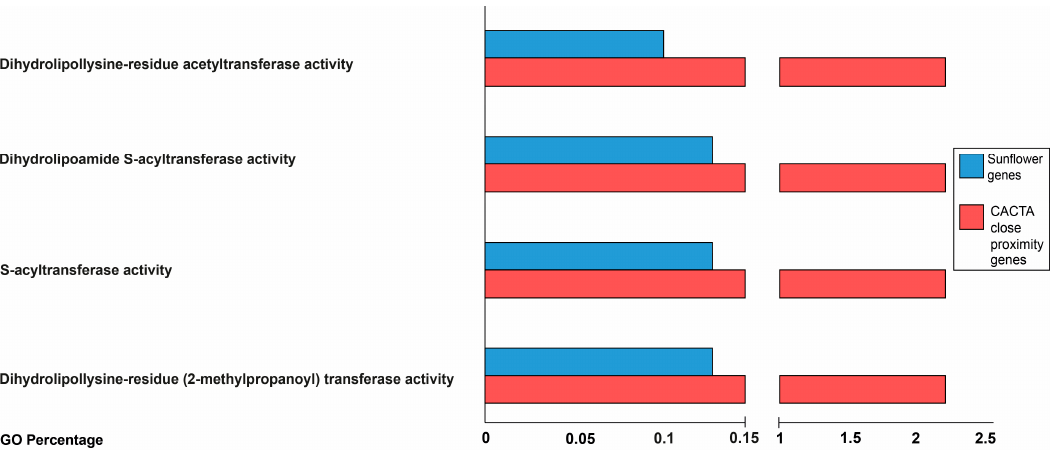
Figure 6. Enriched gene ontology (GO) terms distribution. GO terms of genes in close proximity to elements of CACTA family A (red bars) compared to GO terms of the whole gene set of sunflower (blue bars).